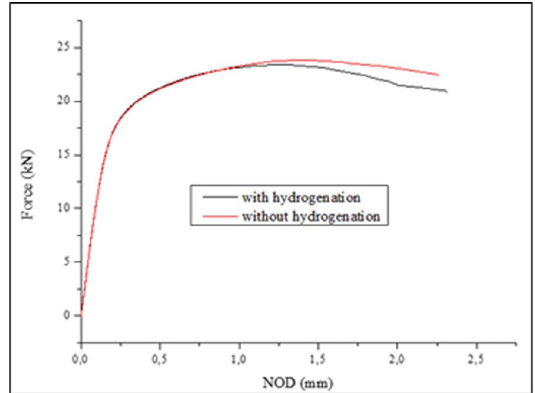
Table 13. Results of CTOD tests of the welded joint, steel ASTM A182 F22 - Inconel 625 - steel ASTM A36, without (OH) and with (WH) hydrogenation.